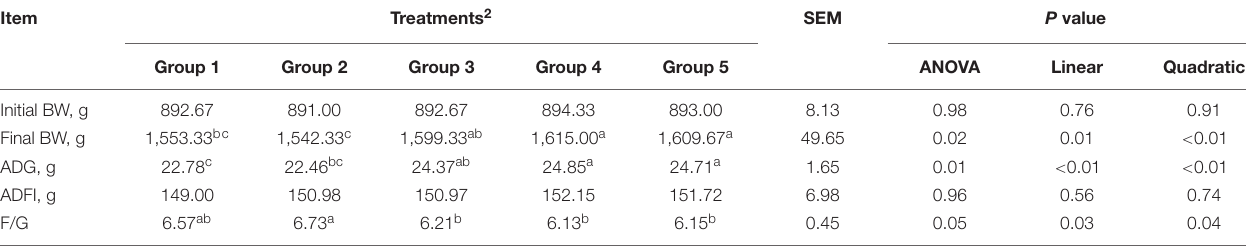
TABLE 2 | Effect of different dietary FA supplementation on growth performance of experimental ducks 1 . Item